Question: Summarize what this figure shows in one sentence.
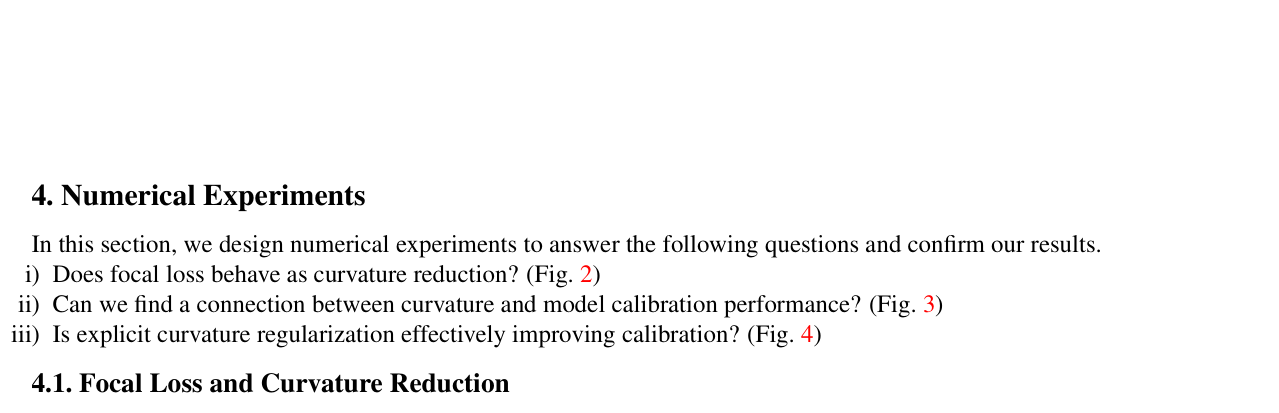
Answer: shows the changes in the maximum eigenvalue of the Hessian, λmax(Hval) , with respect to the hyperparameter γ in focal loss training. Here, Hval denotes the Hessian of the validation loss. As predicted by our theoretical analysis (Theorem 2), λmax(Hval) consistently decreases across all model architectures as γ increases. This confirms that focal loss indeed reduces the curvature of the loss surface.